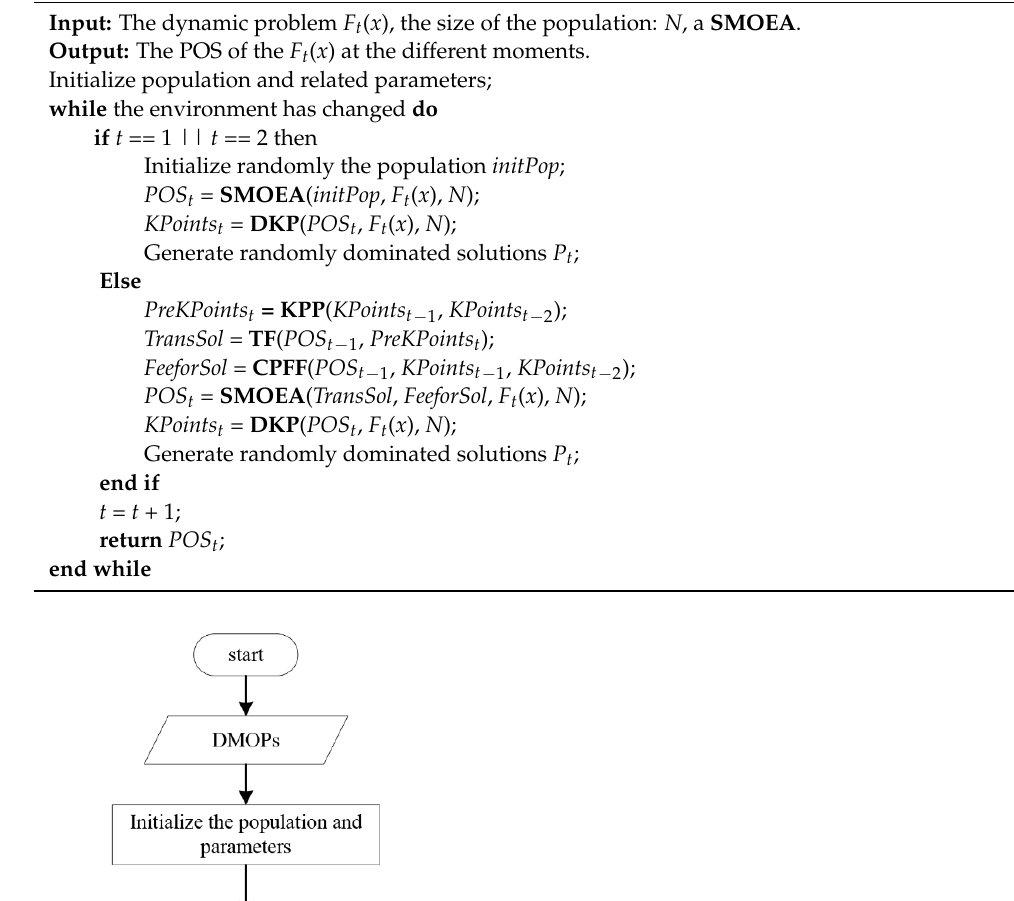
Algorithm 1: The overall framework of KPTHP